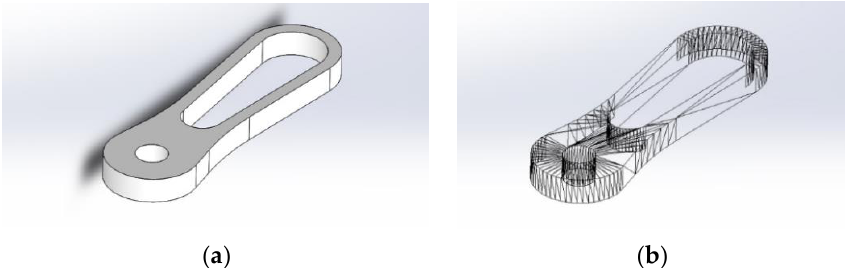
Figure 2. Servo motor first servo arm: ( a ) Visualization in SolidWorks; ( b ) SolidWorks mesh model.